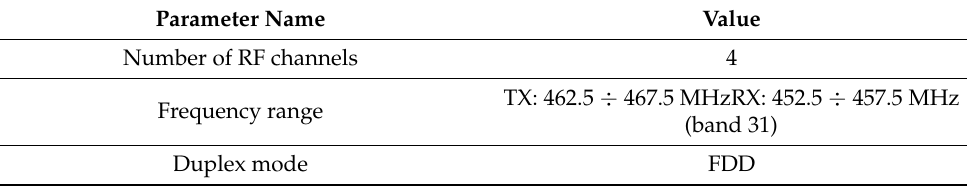
Figure 9. LTE-A 5 MHz output spectrum ( a ) without and ( b ) with DPD enabled for the 465 MHz frequency carrier and the peak power of 10 W at the B31 RF front-end output. Table 3. Measured performances of a single channel of the B31 RF front-end.